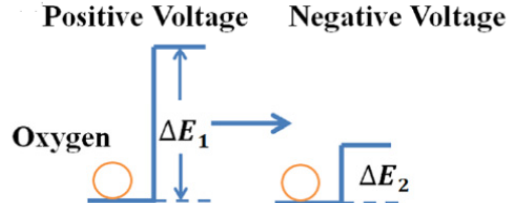
Figure 7. Schematic of oxygen hopping barrier change model for Al / GO / ITO RRAM devices [145] .